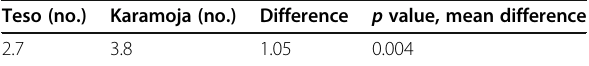
Table 4 Differences in the magnitude of the increase in the number of cattle sold during and after the easing of the lockdown by